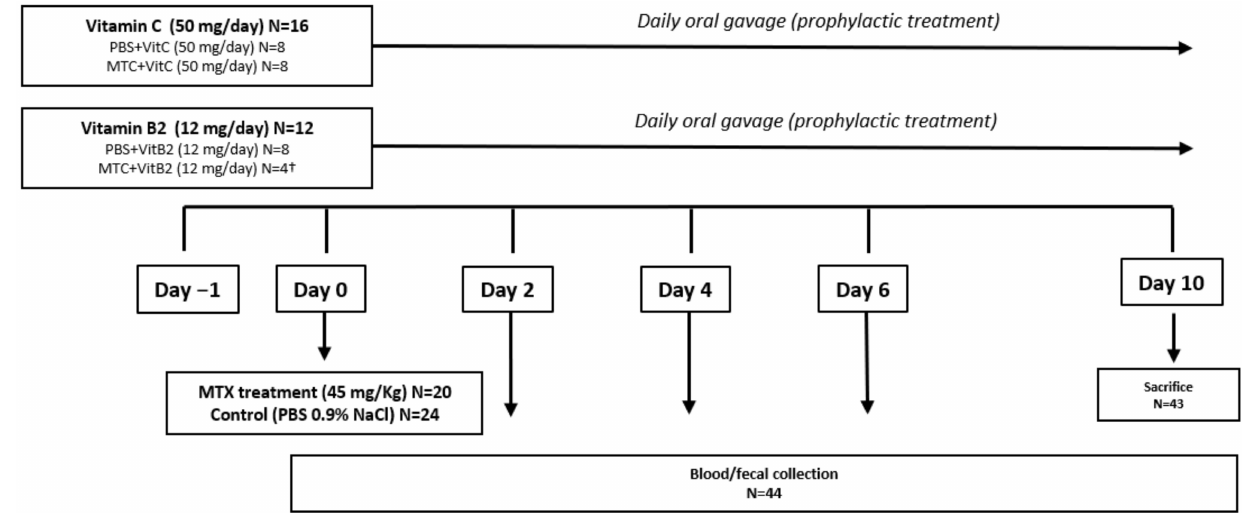
Figure 1. The experimental approach. 8-week-old Wistar male rats were orally gavaged with 50 mg/day vitamin C (N = 16) or 12 mg/day Vitamin B2 (N = 12) every day starting one day before methotrexate (MTX) injection. At days 0, 2, 4, 6 and 10, blood and fecal samples were collected and stored for analysis. At day 10, rats (N = 43) were sacrificed. † At day 3, one animal from MTX+VitB2 group was sacrificed due to severe symptoms. Blood and fecal samples from this animal were collected and results included at day